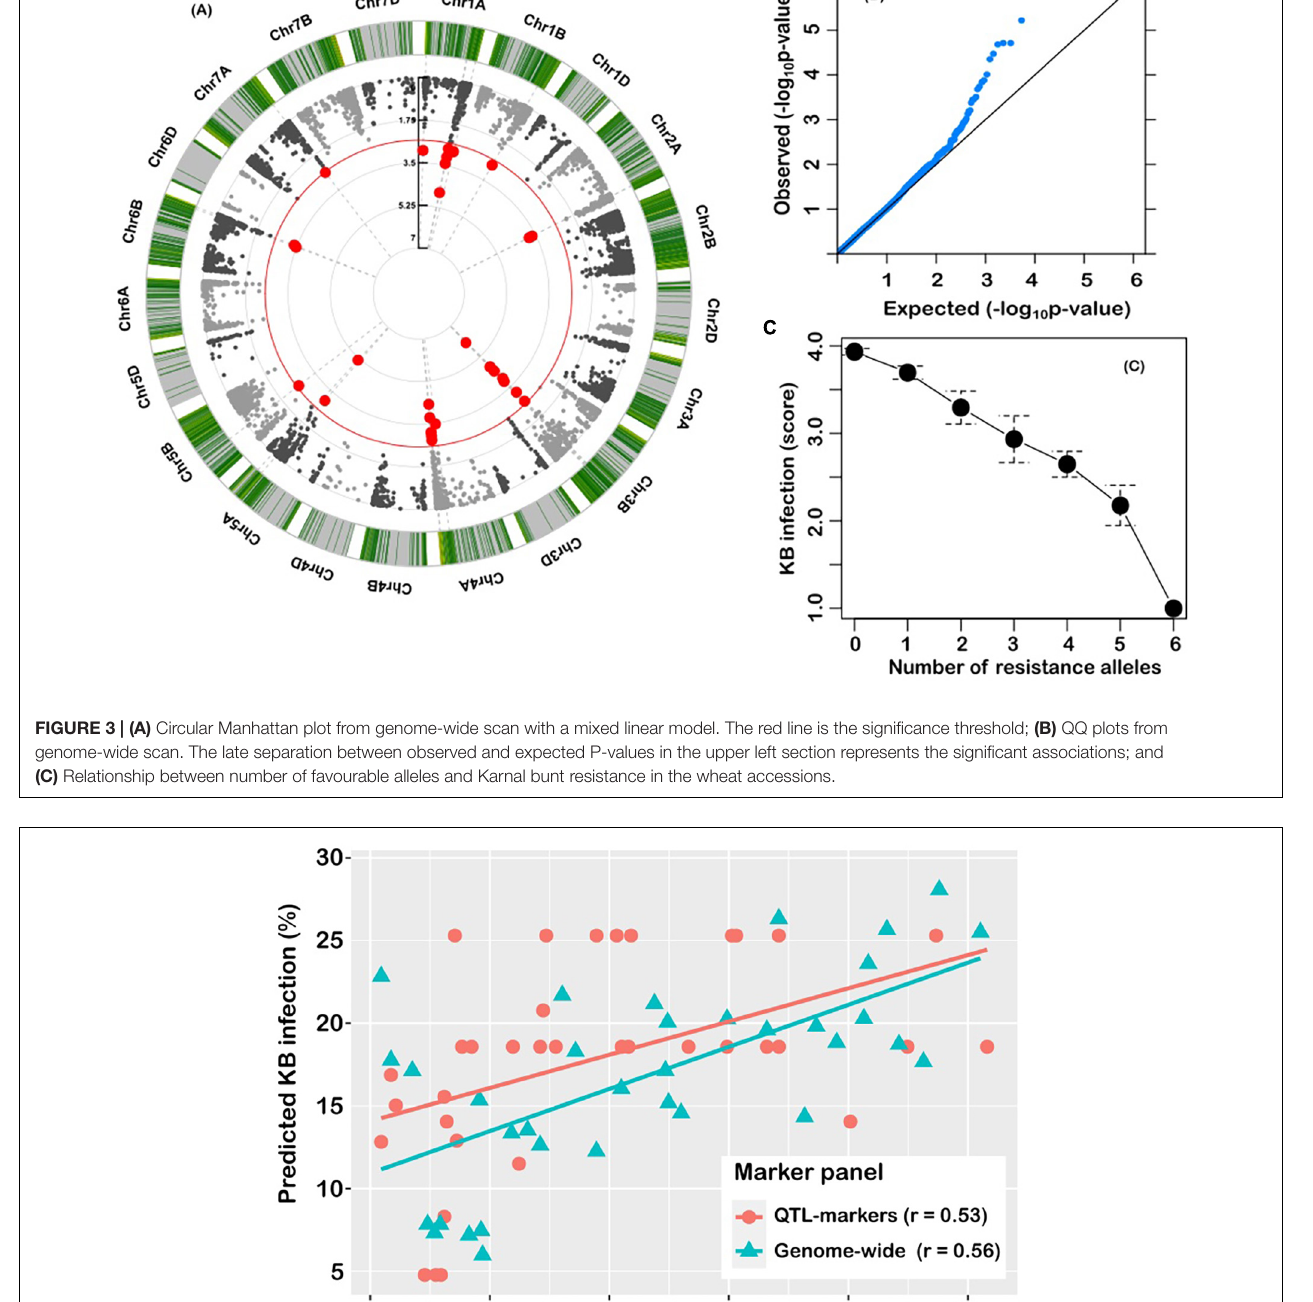
this represents the extent of LD in the population used for this study. It represents the mapping resolution of any QTL detected and was used as the confidence